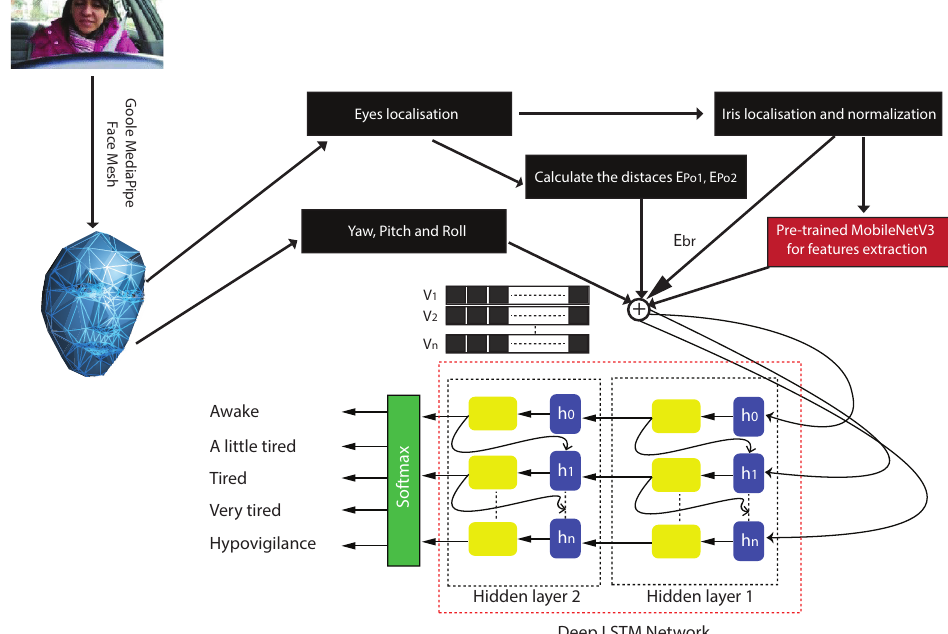
Figure 1. Our proposed model for multilevel driver fatigue detection.